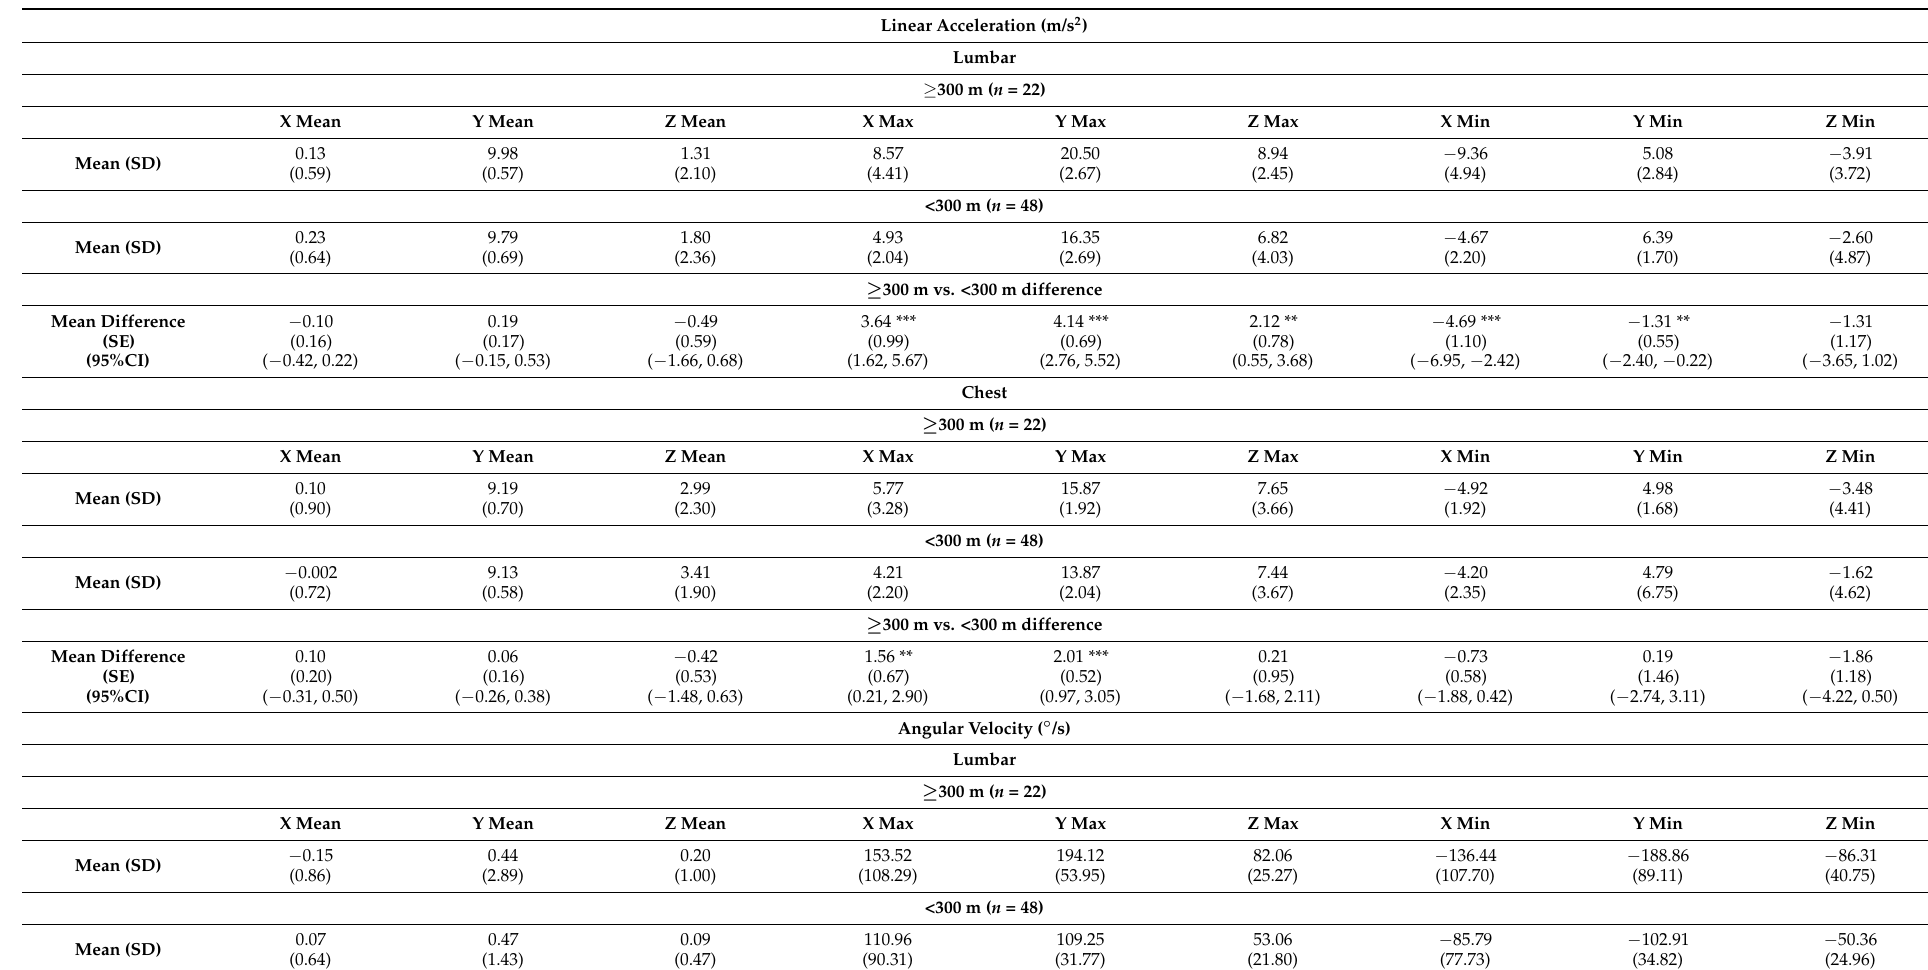
Table 3. Kinematic outcomes differences in the three dimensions between the ≥ 300 m and <300 m groups in the